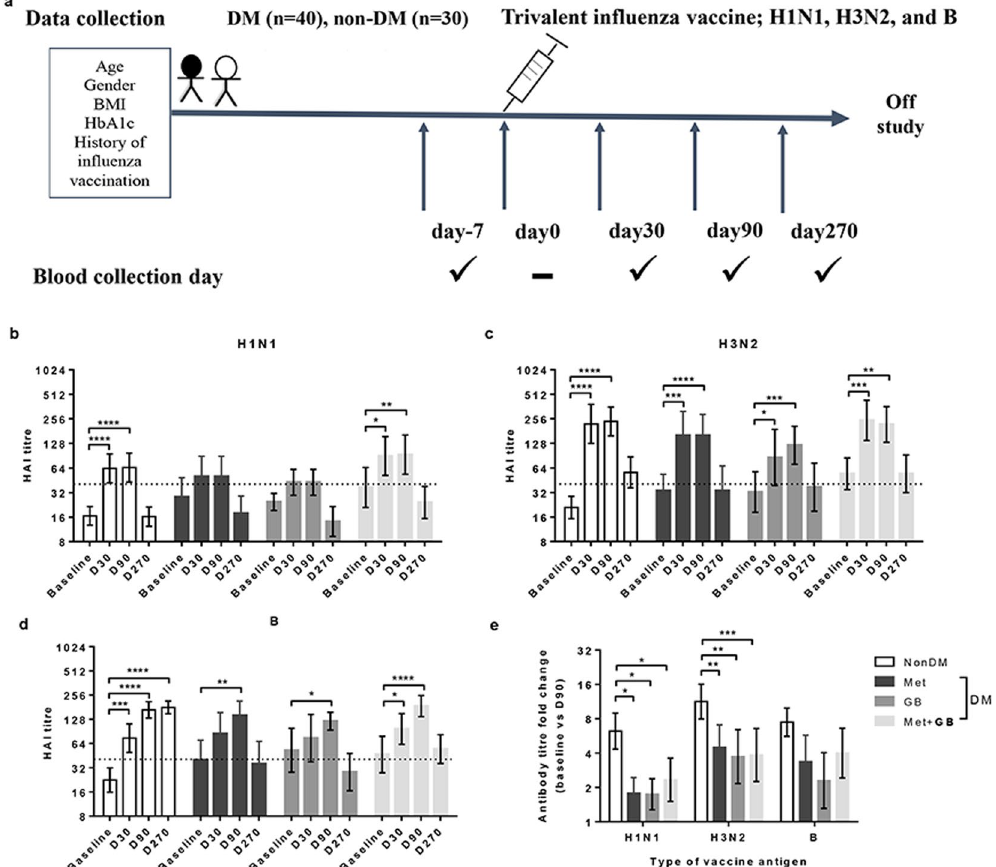
Figure 1. Seasonal vaccination with TIV elicited sero-protection for all groups, but all treated DM groups showed significantly decreased responses against H1N1 and H3N2, in addition to delaying and reducing haemagglutination inhibition (HAI) persistency against influenza B antigen in metformin-DM and glibenclamide-DM. (a) Study design indicating the sample groups and time of blood collection before and after seasonal vaccination with TIV (schematic). Blood samples were collected from Thai individuals with and without T2DM at baseline (day -7) and post-vaccination with TIV (day 0). Antibody responses were evaluated by the HAI assay at baseline, as well as 30, 90, and 270 days post-vaccination against influenza (b) H1N1, (c) H3N2, or (d) B-antigen and compared with non-DM individuals and T2DM patients prescribed metformin (Met; n = 12) or glibenclamide (GB; n = 10), or a combination of the two drugs (Met + GB; n = 18). The dotted line represents the protective threshold HAI titre of 40. (e) HAI antibody titre fold-change (baseline vs . D90) against influenza H1N1, H3N2, or B-antigens compared among all four groups. Comparison of percentage (%) Statistical analyses were undertaken using one-way ( b–d ) or two-way ( e) ANOVA. Horizontal lines represent the geometric mean with 95% CI. * p < 0.05; ** p < 0.01; *** p < 0.001; **** p <